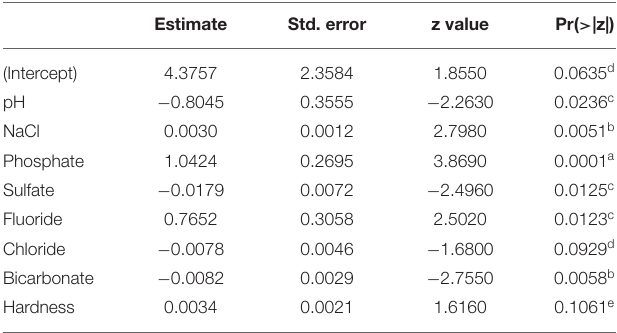
TABLE 3 | The summary of the best-fitted model.